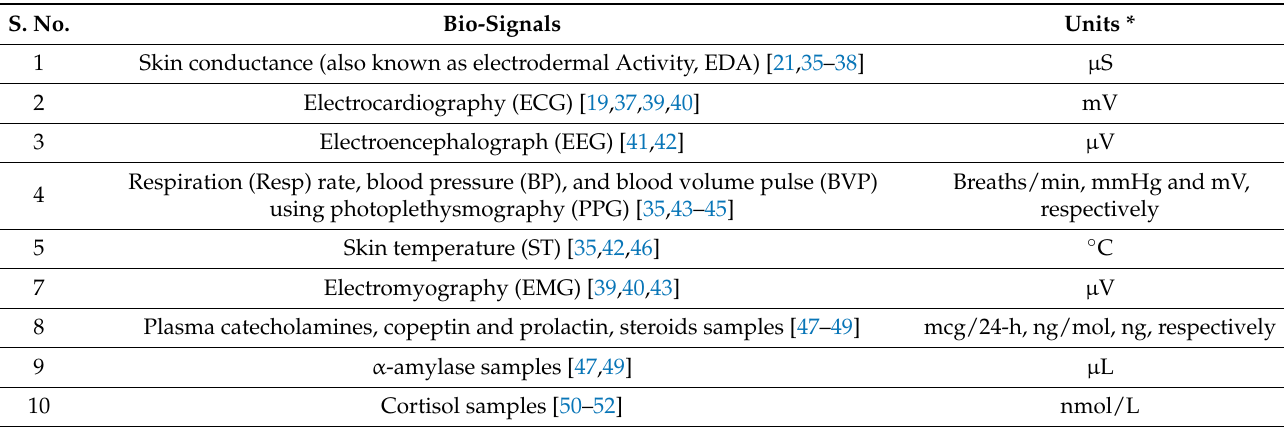
Table 2. Most commonly used bio-signals for stress monitoring.